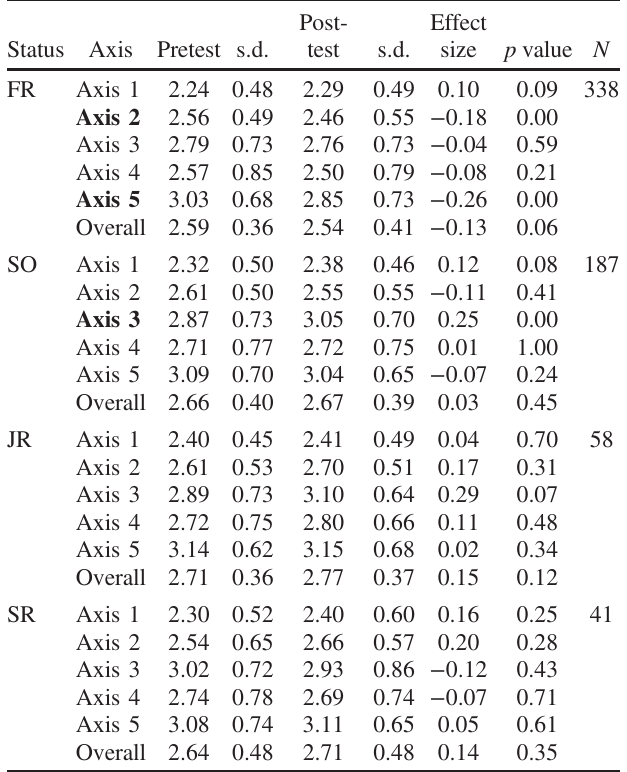
TABLE XI. EBAPS modified spring pretest and post-test results by status. a